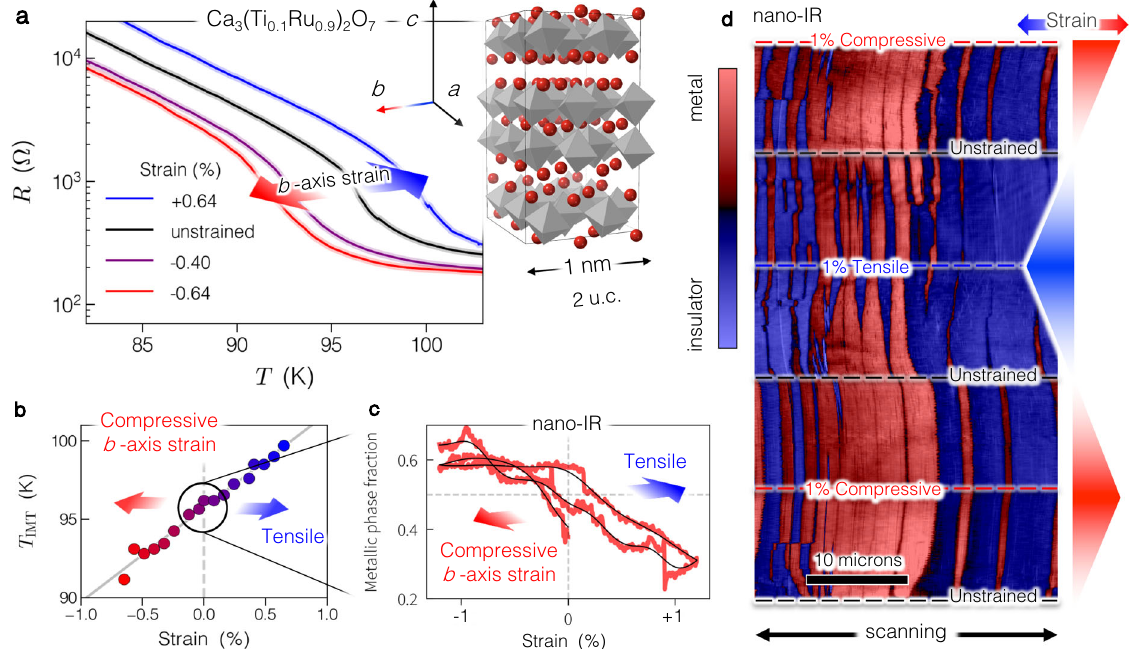
Fig. 2 Strain modulation of the Mott transition. a Two-probe electrical resistance of the crystal in Fig. 1 across the insulator-metal transition under compressive ( ε < 0 ) and tensile ( ε > 0 ) b -axis strain conditions; the overall resistive transition shifts in temperature. Crystallographic axes are labeled on eight rendered unit cells of the crystal structure. b Insulator-metal transition temperature T MIT (identi fi ed by a peak in R (cid:3) 1 dR = dT ) identi fi ed versus applied b- axis strain. c Areal metallic phase fraction at T = 95 K identi fi ed by repeatedly nano-imaging along the line identi fi ed in Fig. 1c versus in situ applied strain; phase fractions can be modulated by 40% under a 2% variation in strain. Small arrows indicate the strain sweep sequence. d Spatially resolved insulator-metal nano-texture along the same scan line quanti fi ed in ( c ) versus dynamically tuned strain; beginning from an unstrained state (bottom) metallic domains enlarge under ε ¼ (cid:3) 1 % compressive strain, then diminish under ε ¼ þ 1 % tensile strain, and can be reversibly restored under renewed compressive